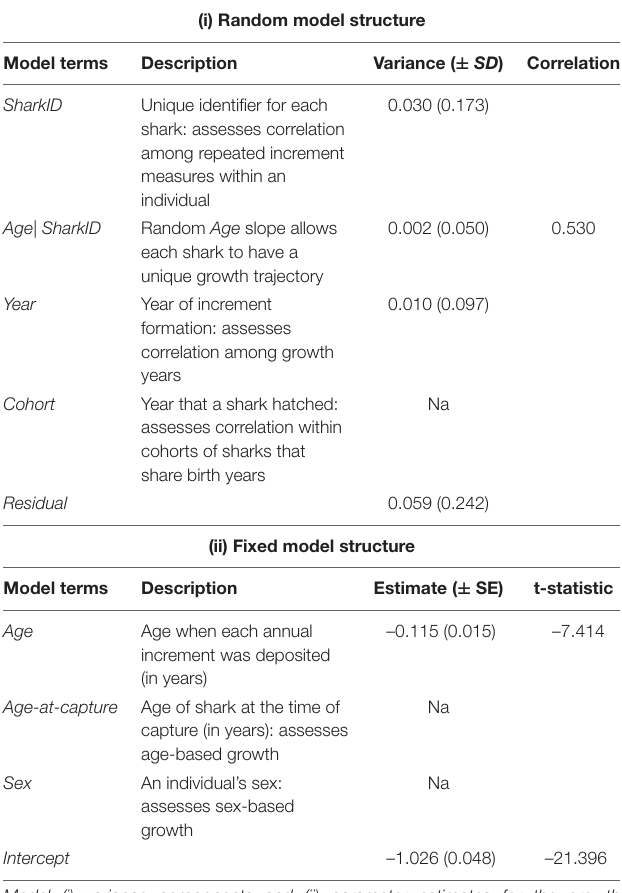
TABLE 1 | Descriptions of the mixed effects model